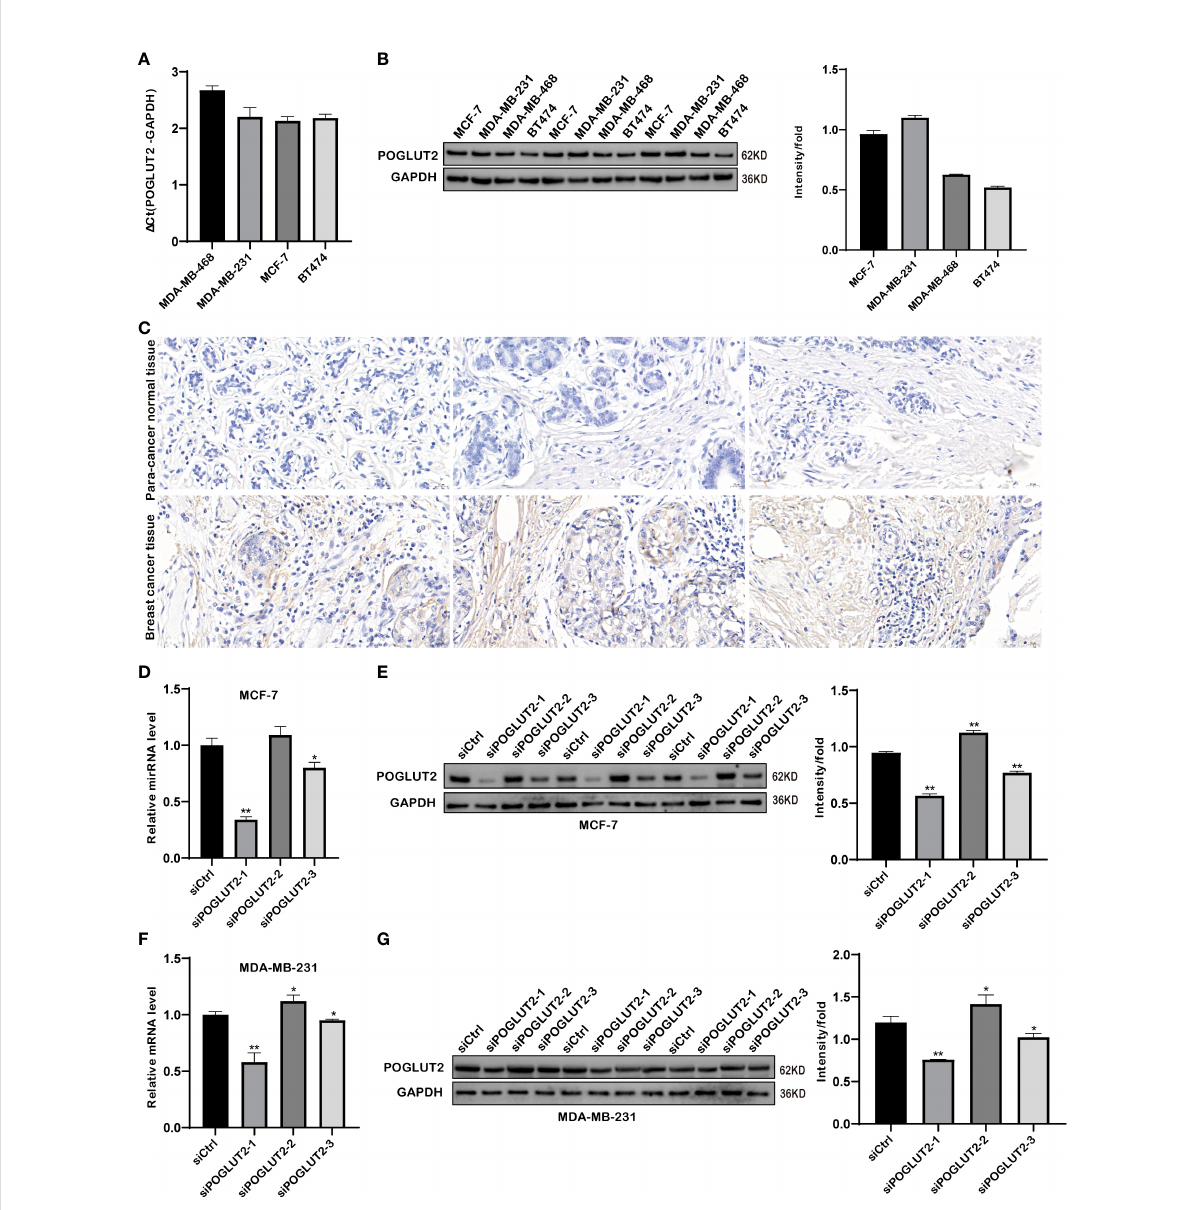
FIGURE 8 Gene and protein expression evaluation of POGLUT2 in breast cancer cells and tissues. (A) Gene expression of POGLUT2 was determined in four breast cancer cell lines, including MDA-MB-468, MDA-MB-231, MCF-7, and BT474, and highest expression was found in MCF-7 cells. (B) Protein expression of POGLUT2 was determined in four breast cancer cell lines, including MDA-MB-468, MDA-MB-231, MCF-7, and BT474, and highest expression was found in MDA-MB-231 cells. (C) Immunohistochemistry analysis of POGLUT2 in breast cancer tissues compared to control tissues. (D) Signi fi cant POGLUT2 expression downregulation was found in MCF-7 cells after siRNA transfection. (E) Signi fi cantly POGLUT2 expression downregulation was found in MDA-MB-231 cells after siRNA transfection. (F) Signi fi cantly POGLUT2 protein level downregulation was found in MCF-7 cells after siRNA transfection. (G) Signi fi cantly POGLUT2 protein level downregulation was found in MDA- MB-231 cells after siRNA transfection. * p < 0.05; ** p <